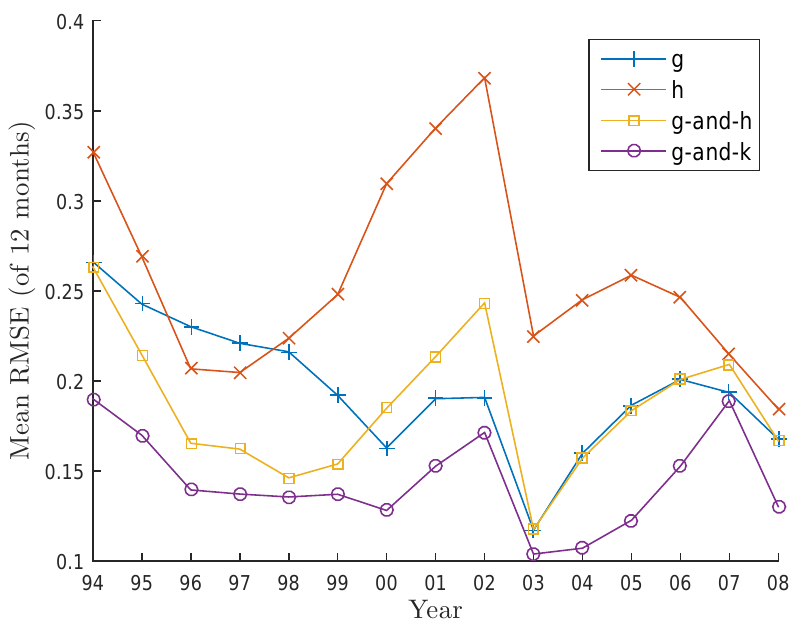
Figure 5. Time series plots of the mean root-mean-square-error (RMSE) over the years, where each line corresponds to a model, and where each marker corresponds to a mean RMSE value calculated by averaging across the months in a